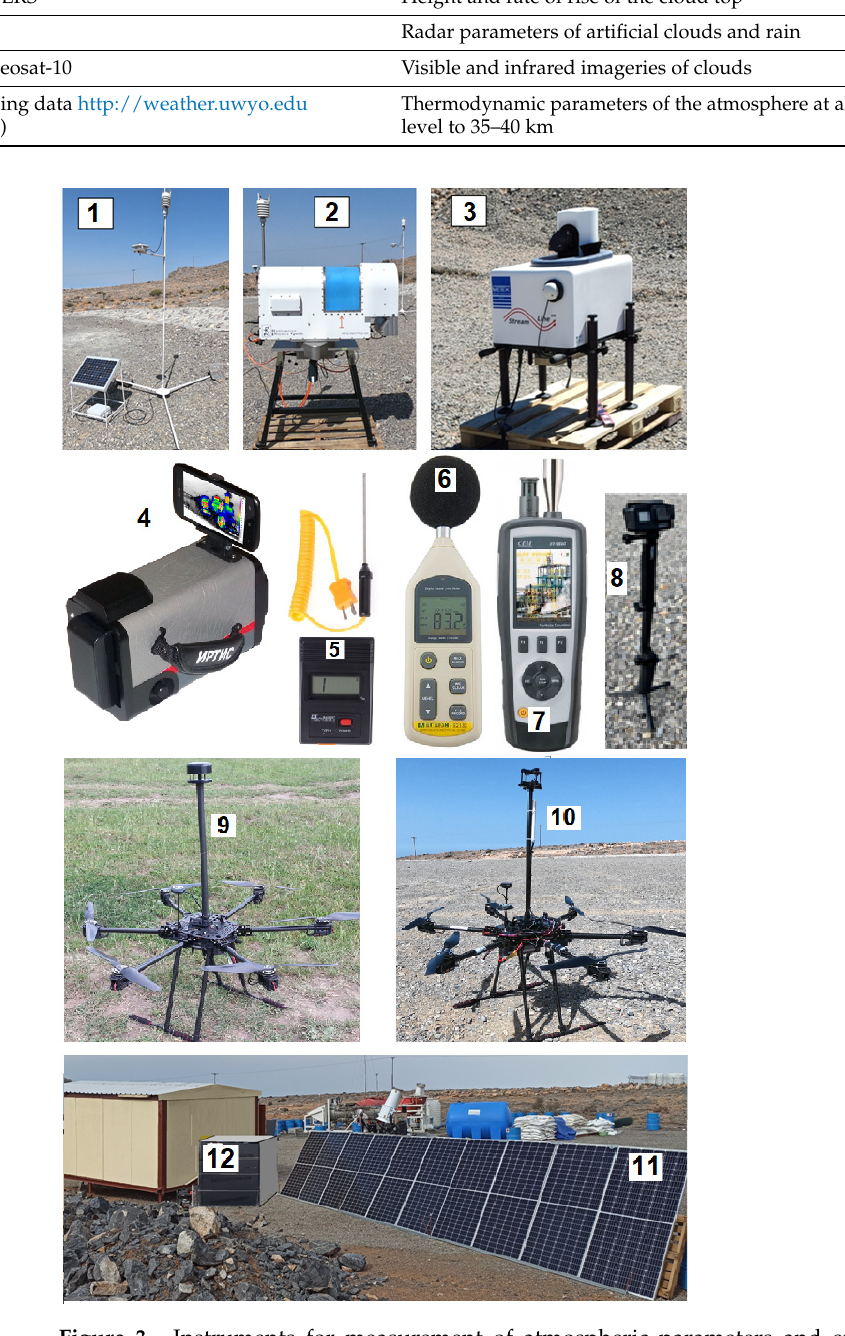
Figure 3. Instruments for measurement of atmospheric parameters and experiments control: 1 — automatic weather station Vaisala WXT-536 with pyranometerRK200-03; 2 —multi-microwave radi-